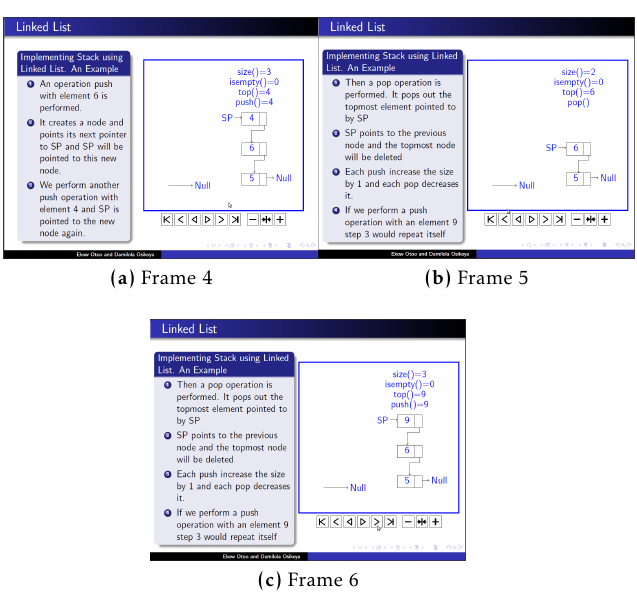
Figure 5. Stack Implementation (Linked List)